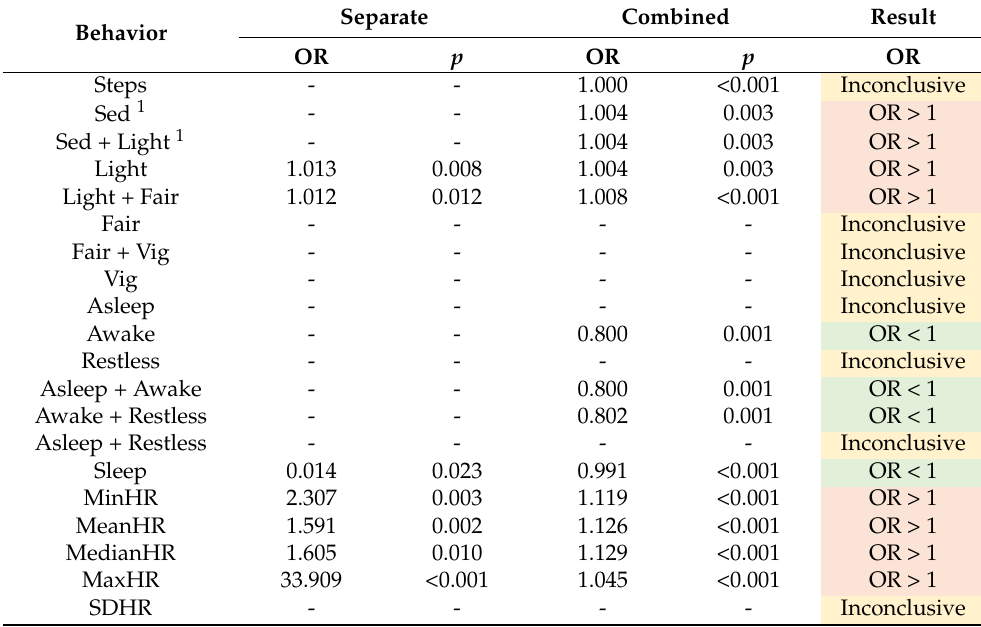
Table A9. Results across all conditional logistic regression models in validation scenario type 1.